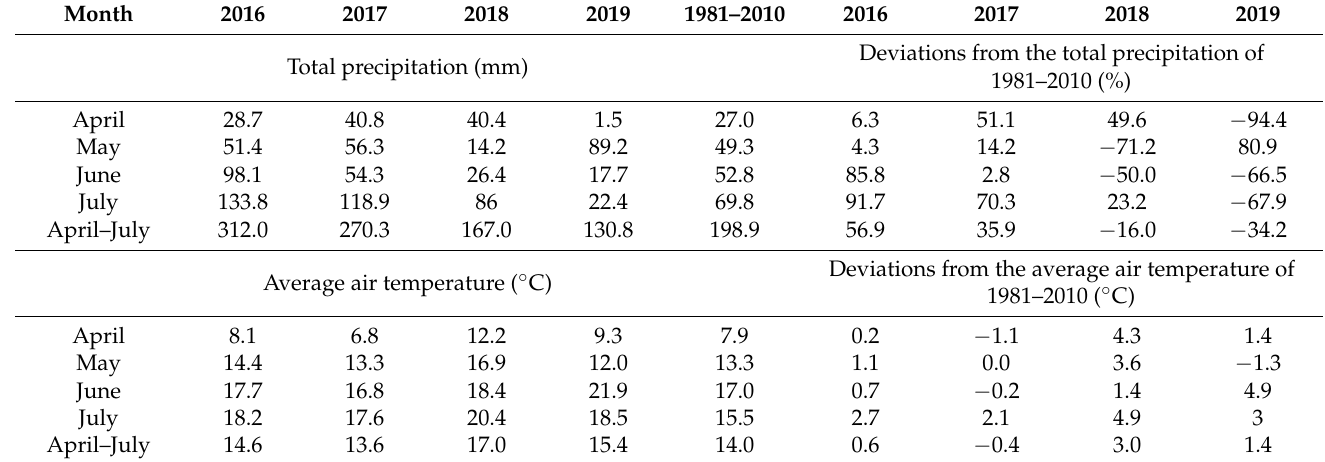
Table 2. Weather conditions at the experiment